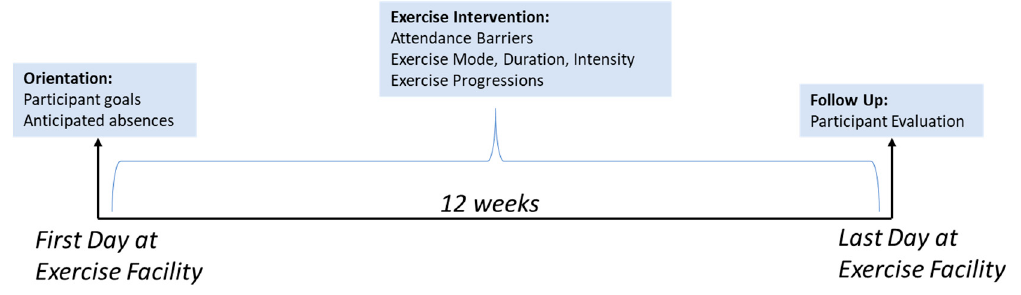
Figure 1. Study timeline and measures .